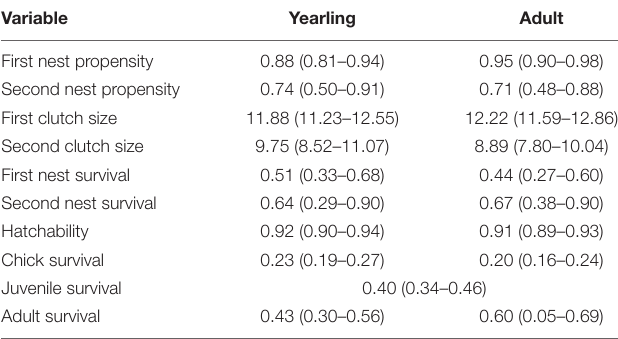
TABLE 1 | Estimated vital rates (with 95% credible intervals) for each stage class (yearling and adult) of sharp-tailed grouse in eastern Montana using a female-based integrated population